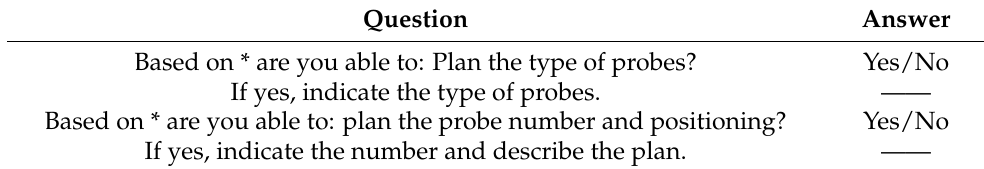
Table 2. Traditional/Virtual Plan